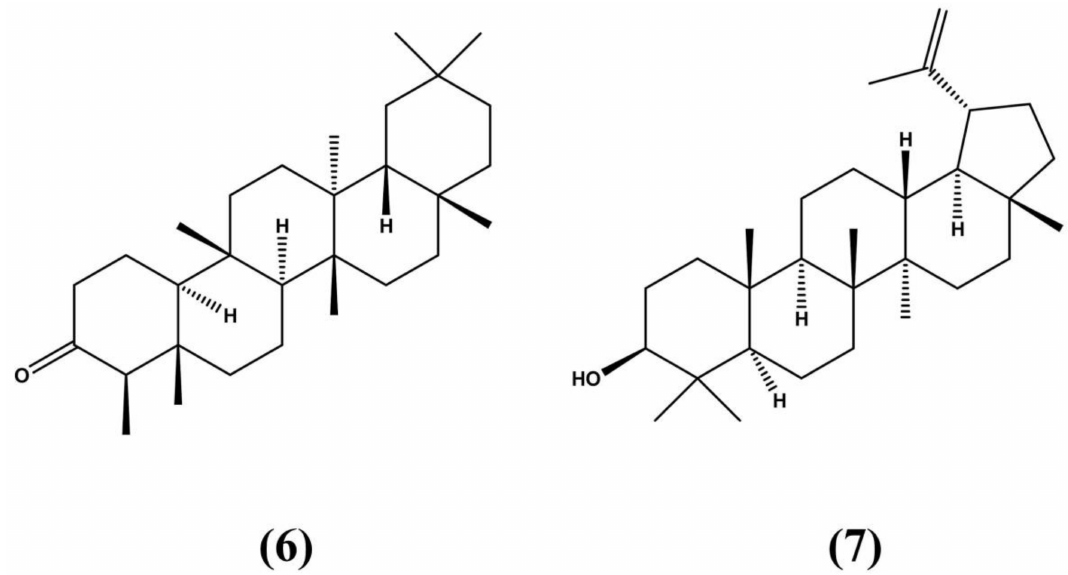
Figure 4. The triterpenoids friedelin ( 6 ) and lupeol ( 7 ) isolated and described in E. ovalifolium extracts